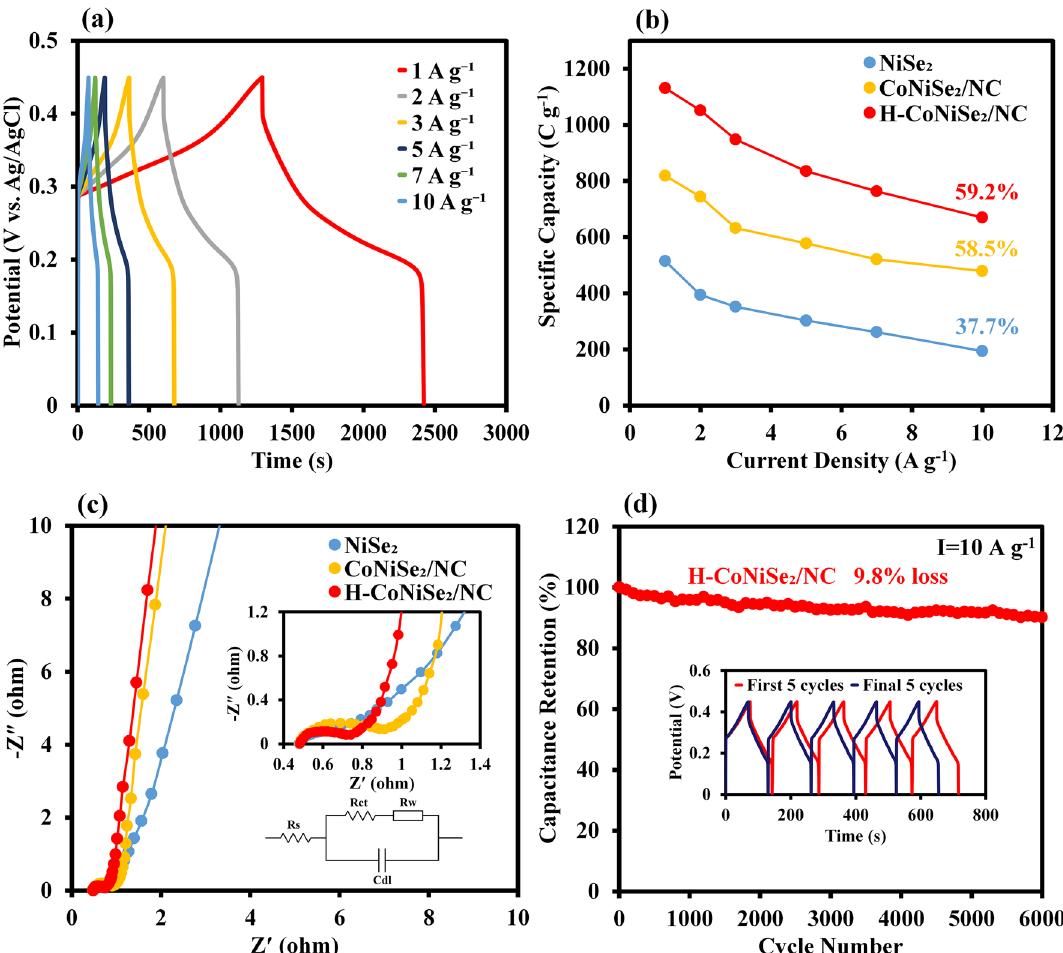
Figure 6. ( a ) GCD curves of H-CoNiSe 2 /NC at various current densities. ( b) Specific capacities of H-CoNiSe 2 / NC, CoNiSe 2 /NC, and NiSe 2 . ( c ) Nyquist plots of H-CoNiSe 2 /NC, CoNiSe 2 /NC, and NiSe 2 . ( d ) Cycling performance of H-CoNiSe 2 /NC at 10 A/g (inset: GCD curves of the first five cycles and the last five evaluate the transport characteristics of the samples. The corresponding EIS plots with the equivalent circuit model are shown in Fig. 6c. As specified in the model, the R ct value is an important factor in evaluating the electrodes’ conductivity and is obtained from the diameter of the semicircle at the high-frequency region. The internal resistance (R s ) is determined from the intersection of the EIS curve with the Z ʹ axis. The slope of the diagonal line at the low-frequency region is related to the Warburg resistance (R w ), resulting from ions/electro- lyte diffusion over electrochemical processes. The impedance spectra in the semicircle region illustrate that the H-CoNiSe 2 /NC electrode has a lower R ct (0.25 Ω) than CoNiSe 2 /NC (0.43 Ω) and NiSe 2 (0.52 Ω), indicating faster reaction kinetics and remarkable electrical conductivity due to the synergistic effect between Ni and Co ions and the presence of porous carbon in the composite. The steeper slope of the H-CoNiSe 2 /NC electrode compared to other electrodes in the linear region indicates more diffusion of ions to the electrode surface, which the empty spaces in the structure facilitate the transport of ions and electrons. At 10 A/g, 6000 consecutive cycles were performed to achieve the cyclic stability of the H-CoNiSe 2 /NC electrode. The results in Fig. 6d illustrate that the H-CoNiSe 2 /NC electrode retains 90.2% of its initial specific capacity, indicating relatively excellent cyclic stability. The inserted figure in Fig. 6d relates to the charge and